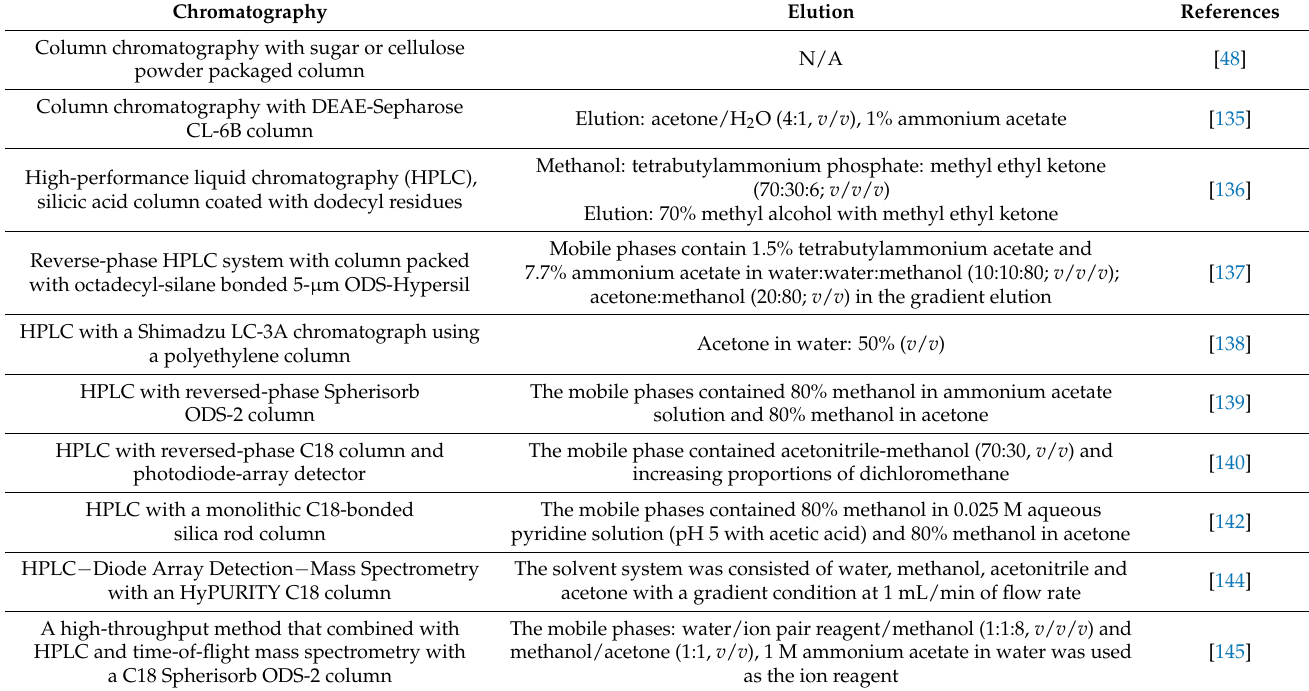
Table 4. Some examples of chlorophyllides purification by